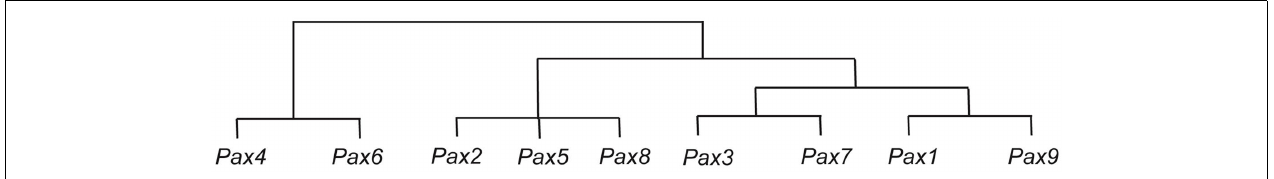
ancestral Pax gene the ancestor of the Pax2 , Pax5 , and Pax8 genes was subsequently derived, followed by the ancestors of the Pax3 and Pax7 genes, and the Pax1 and Pax9 genes (Miller, 1999).